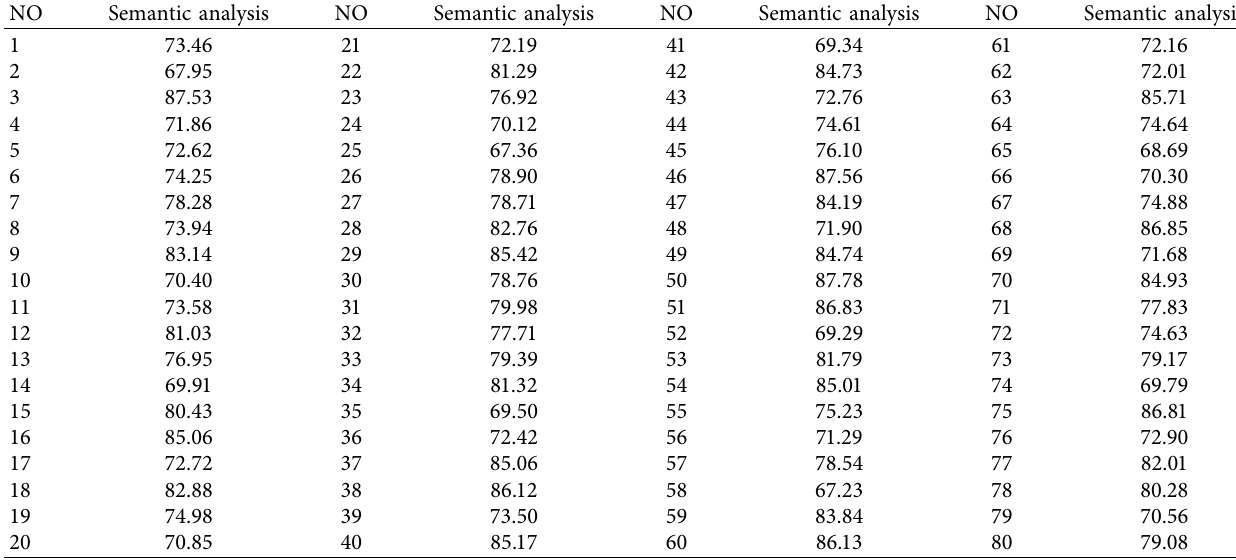
Table 1: English semantic analysis effect of English writing correction model based on intelligent text semantic analysis. NO Semantic analysis